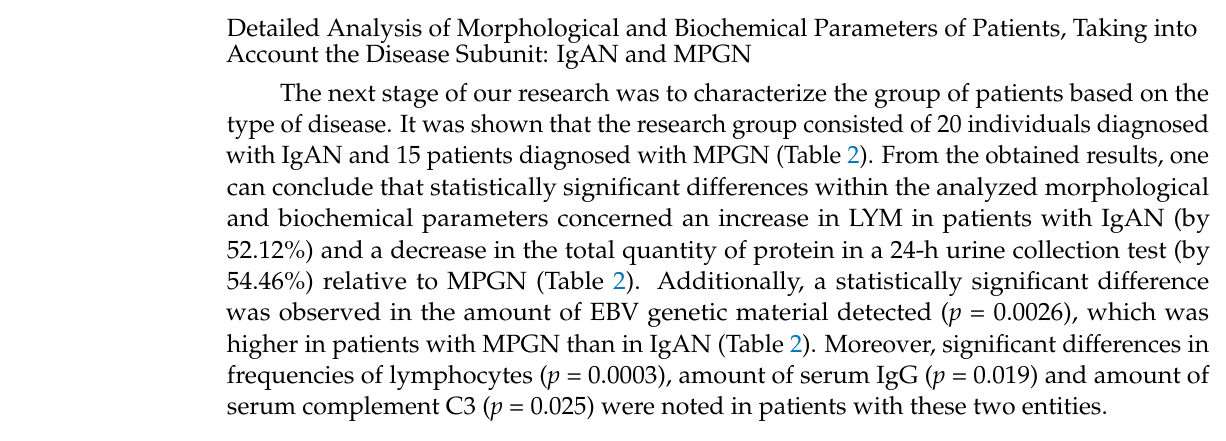
Table 2. Differentiation of morphological and biochemical parameters among patients with GN and the control